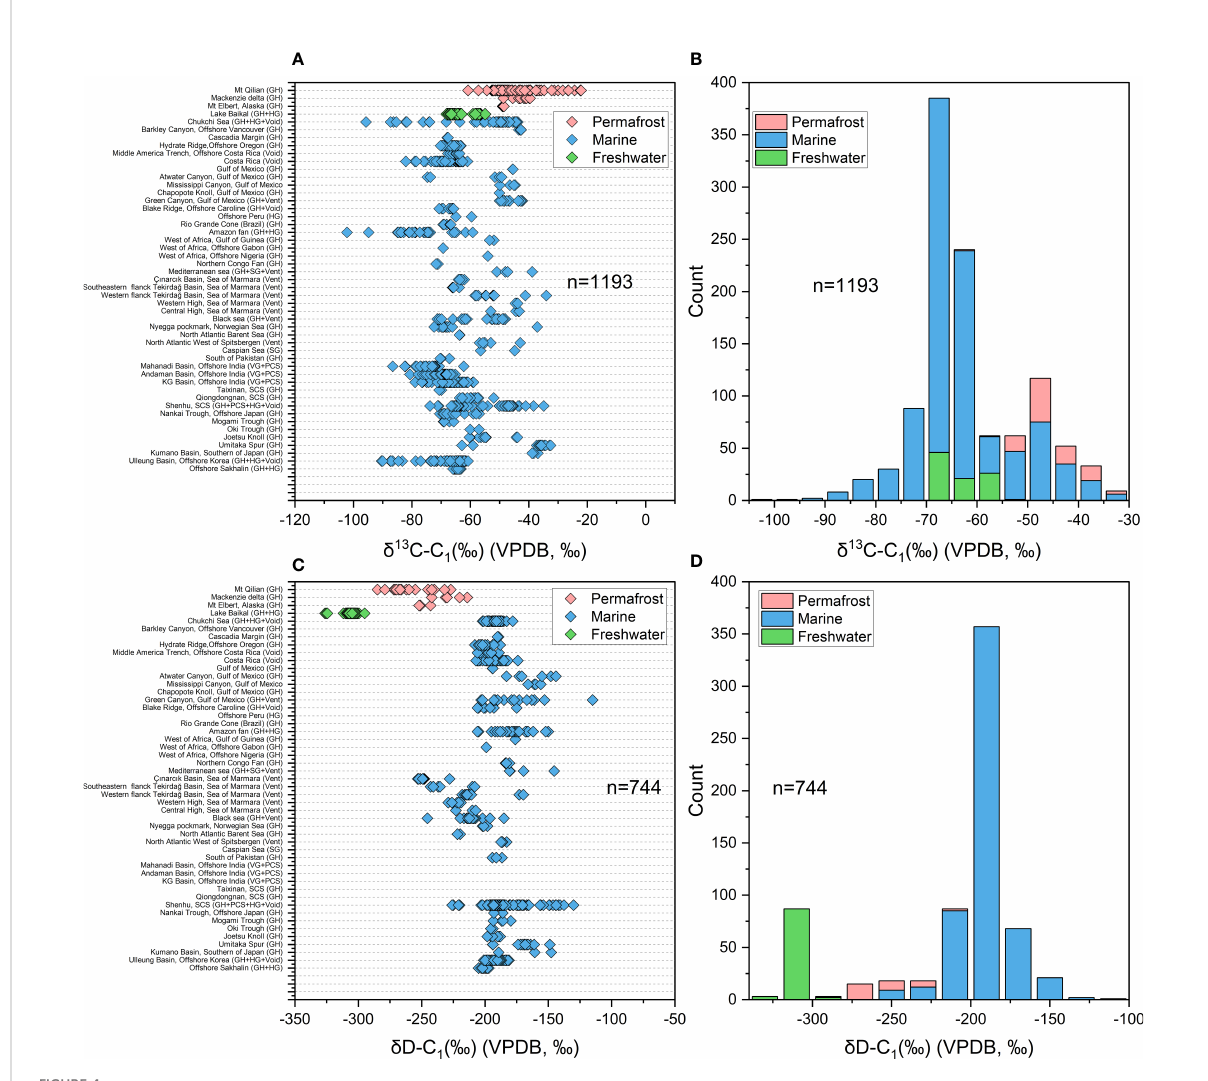
FIGURE 4 (A) The distribution of d 13 C-C 1 of hydrate-associated gas from different area around the world. (B) The frequency histogram of d 13 C-C 1 of hydrate-associated gas counted from 1193 data. (C) The distribution of d D-C 1 of hydrate-associated gas from different area. (D) The frequency histogram of d D-C 1 of hydrate-associated gas counted from 744 data. GH, Gas Hydrate dissociated gases; Vent, Venting Gases; Void, Void gases; HG, Headspace gases; PCS, gas from Pressure coring systems